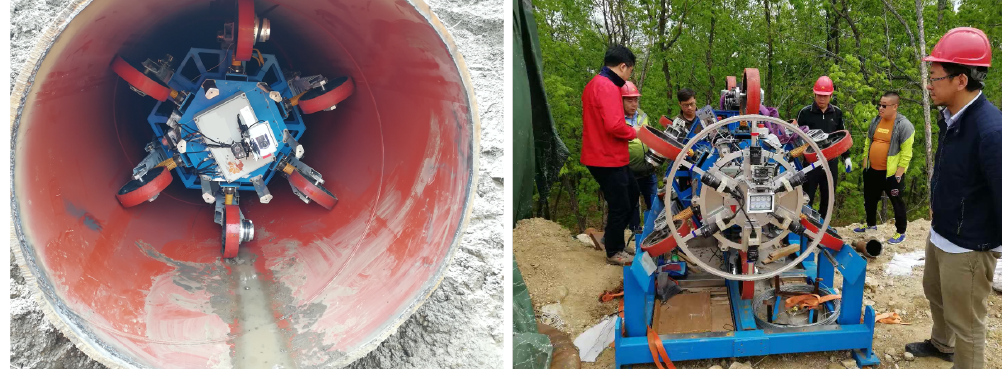
Figure 5. Operation scenes of new inspection